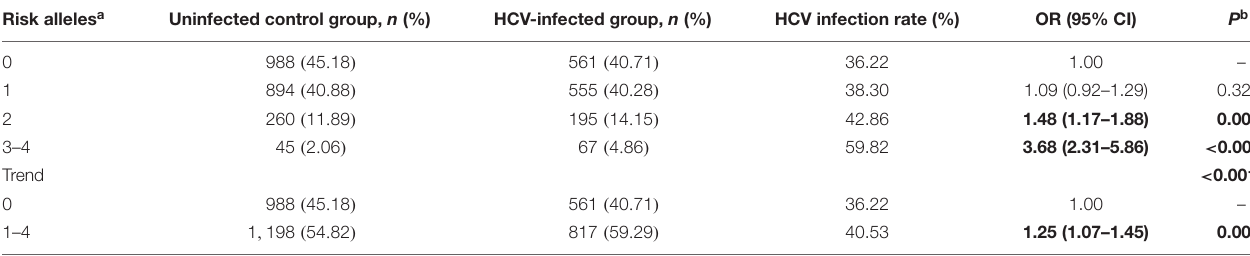
TABLE 3 | The combined effects of risk alleles (rs7514229-T and rs3181366-T) on the risk of HCV infection.